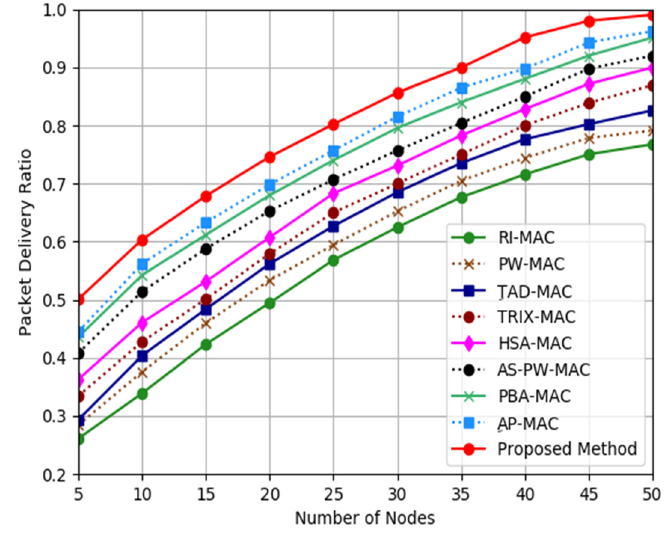
Figure 6. Packet Delivery Ratio Figure 7. Packet Delivery Ratio analysis.